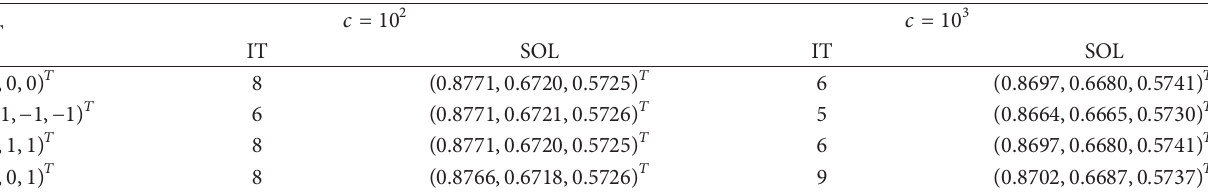
Table 1: Numerical results for Example 1 󸀠 .